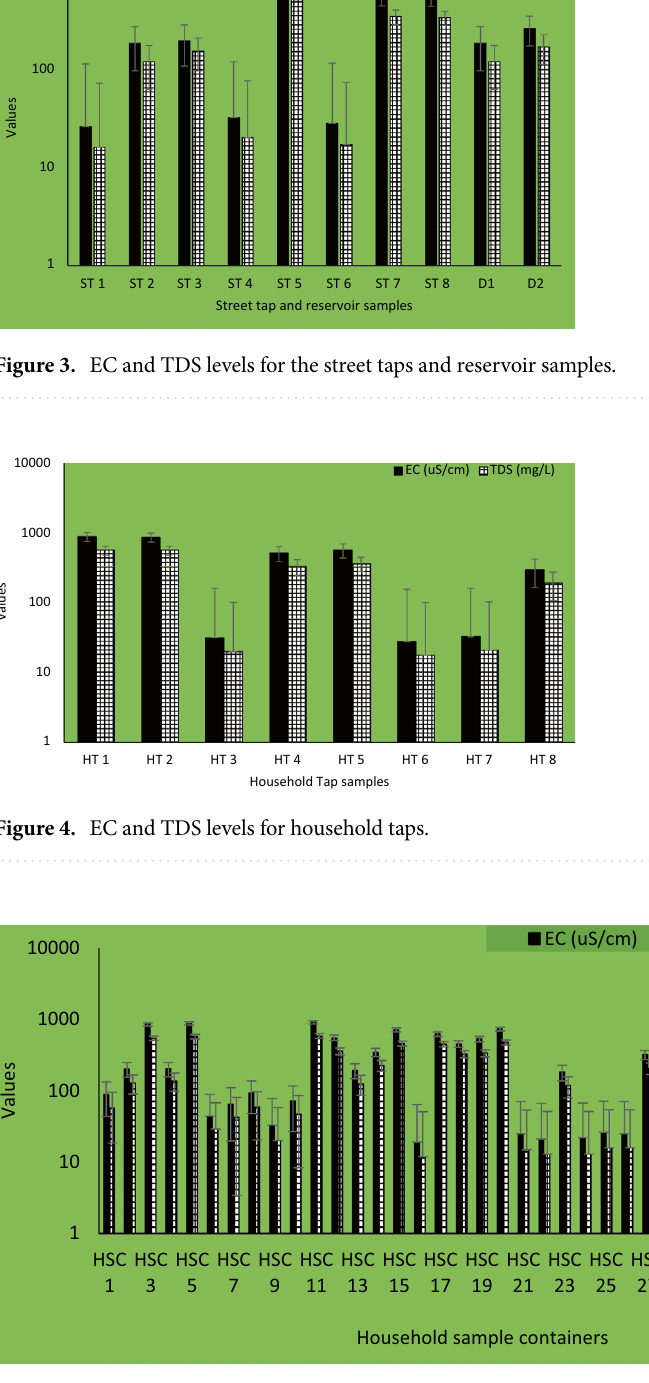
Figure 5. EC and TDS levels for household storage container